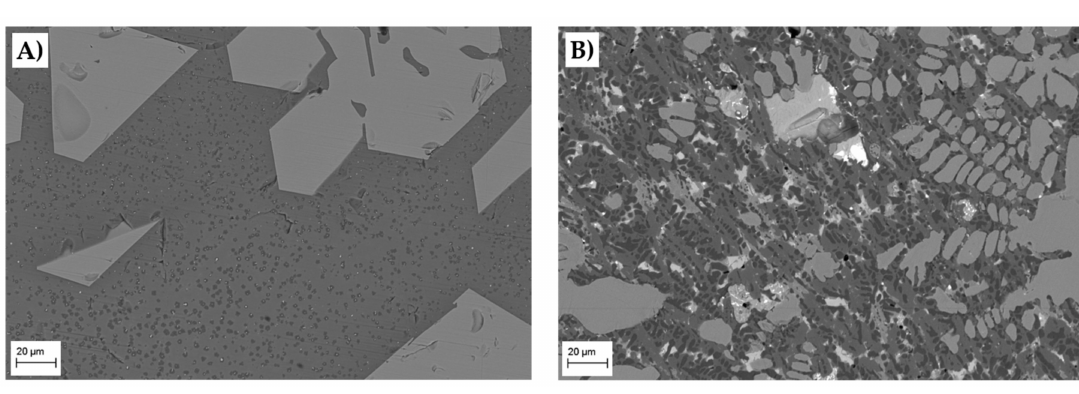
Figure 3. Microstructures of oxidation experiments ( A ) O4 and ( B ) O6. The liquid slag phase is the darker matrix and the solid spinels are the lighter phase areas. The brightest area in ( B ) is a lead-rich metal